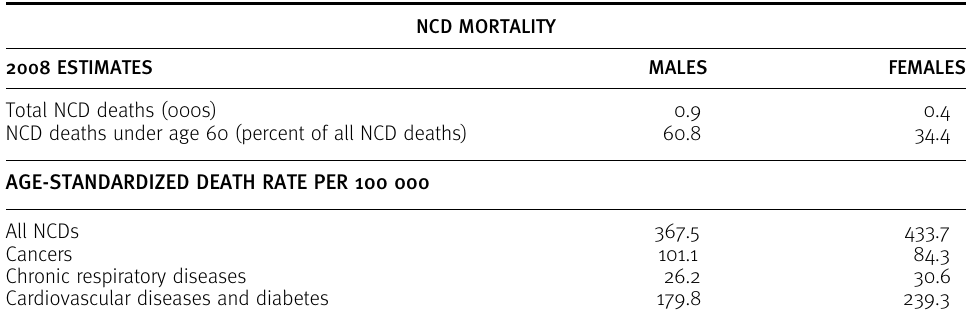
Table 1. Qatar Non Communicable diseases (NCD) Country